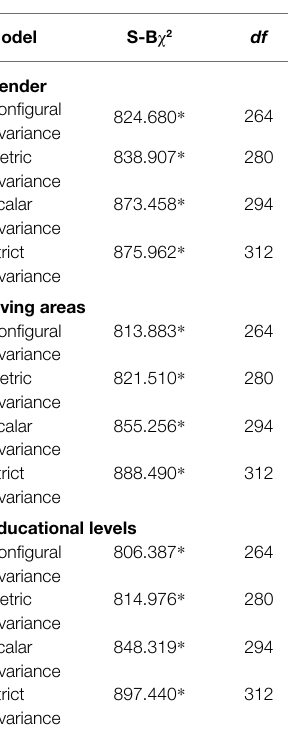
TABLE 5 | Measurement invariance of the